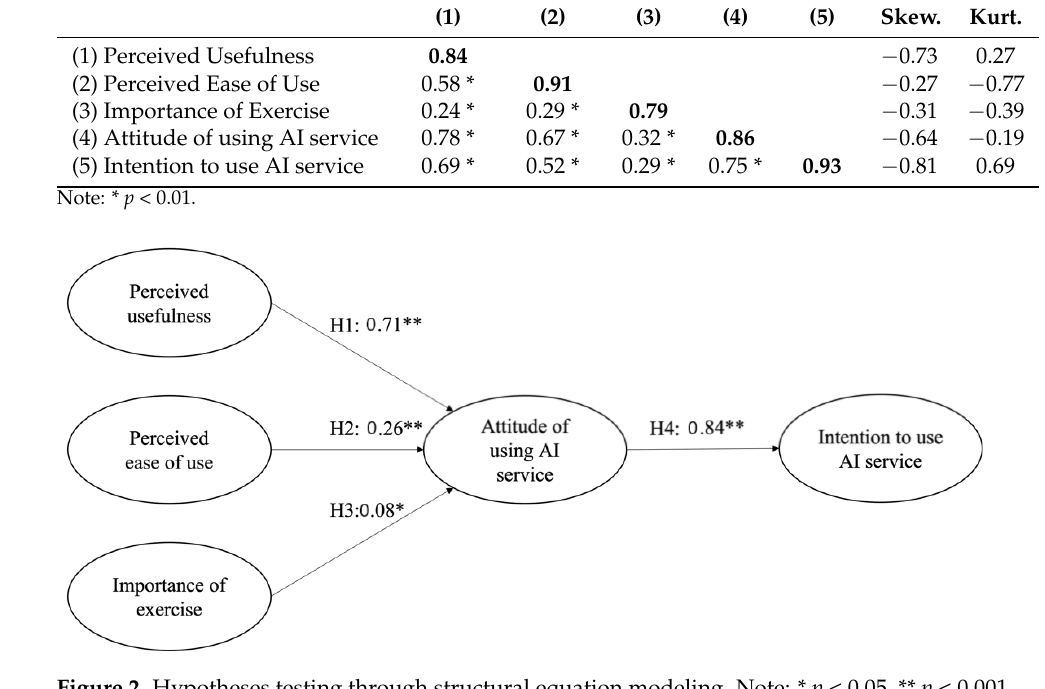
Figure 2. Hypotheses testing through structural equation modeling. Note: * p < 0.05, ** p < 0.001.